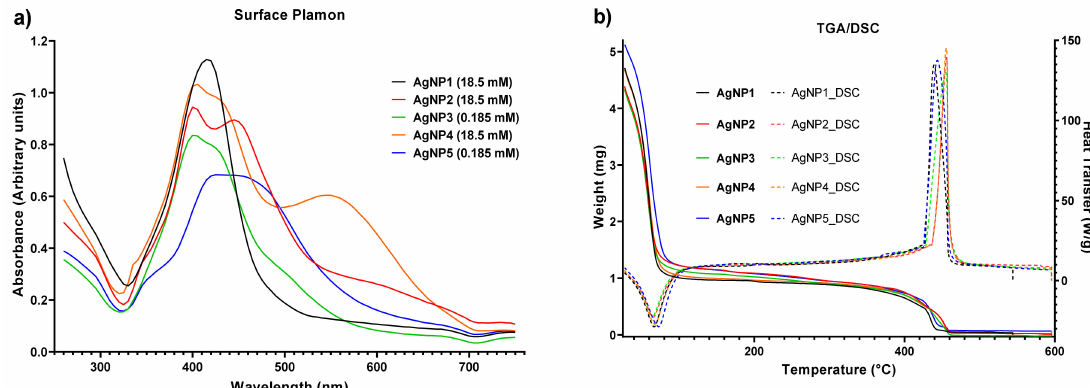
Figure 2. Surface plasmon resonance ( a ) and thermogravimetric analysis (TGA)/differential scanning calorimetry (DSC) ( b ) of the five formulations studied in this work. UV-vis spectra were acquired at different concentrations to assure the absorption values were close to unity. TGA and DSC analysis show the weight loss as a function of temperature and the amount of heat required to increase the temperature of the sample, respectively.